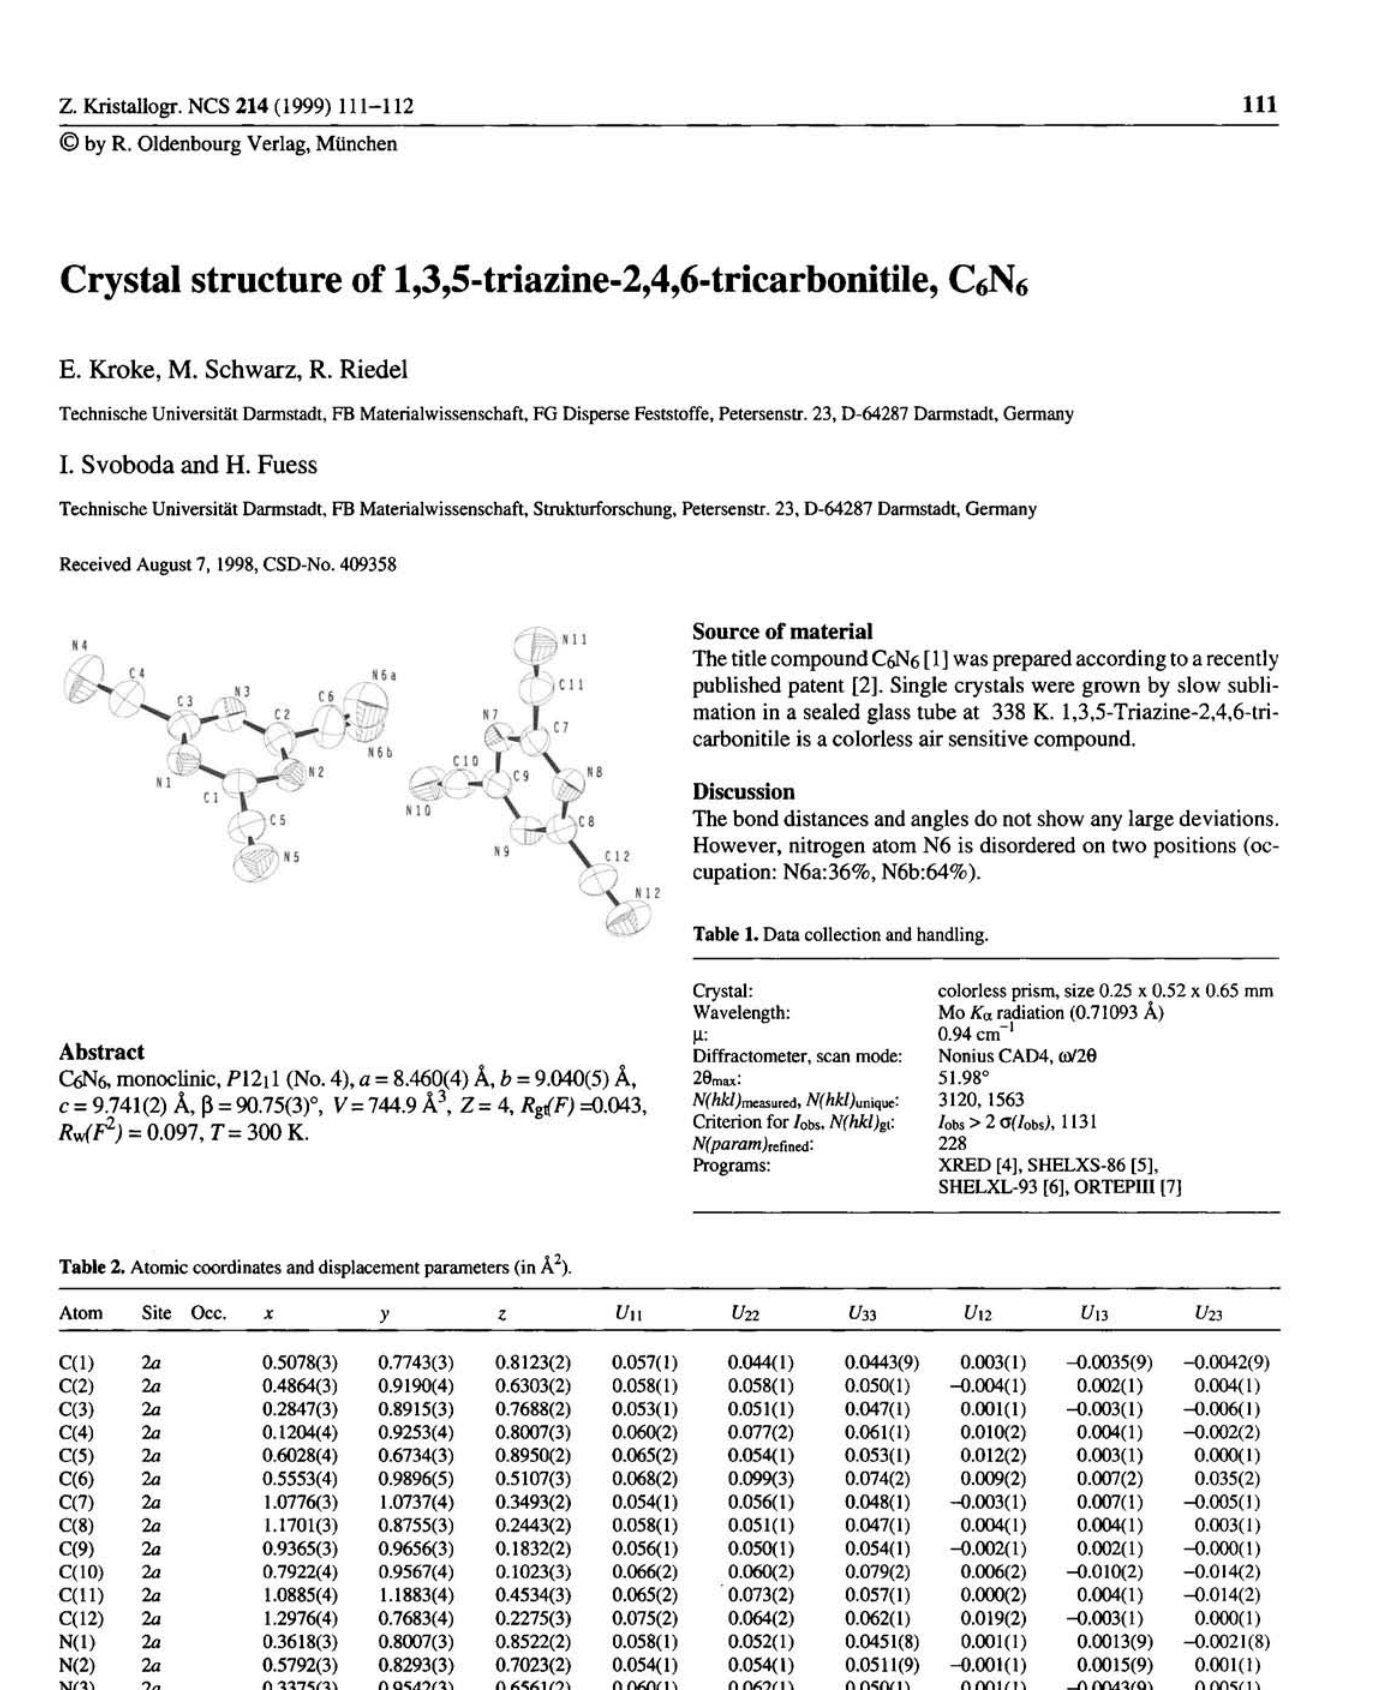
Table 2. Atomic coordinates and displacement parameters (in Â 2 ). Atom Site